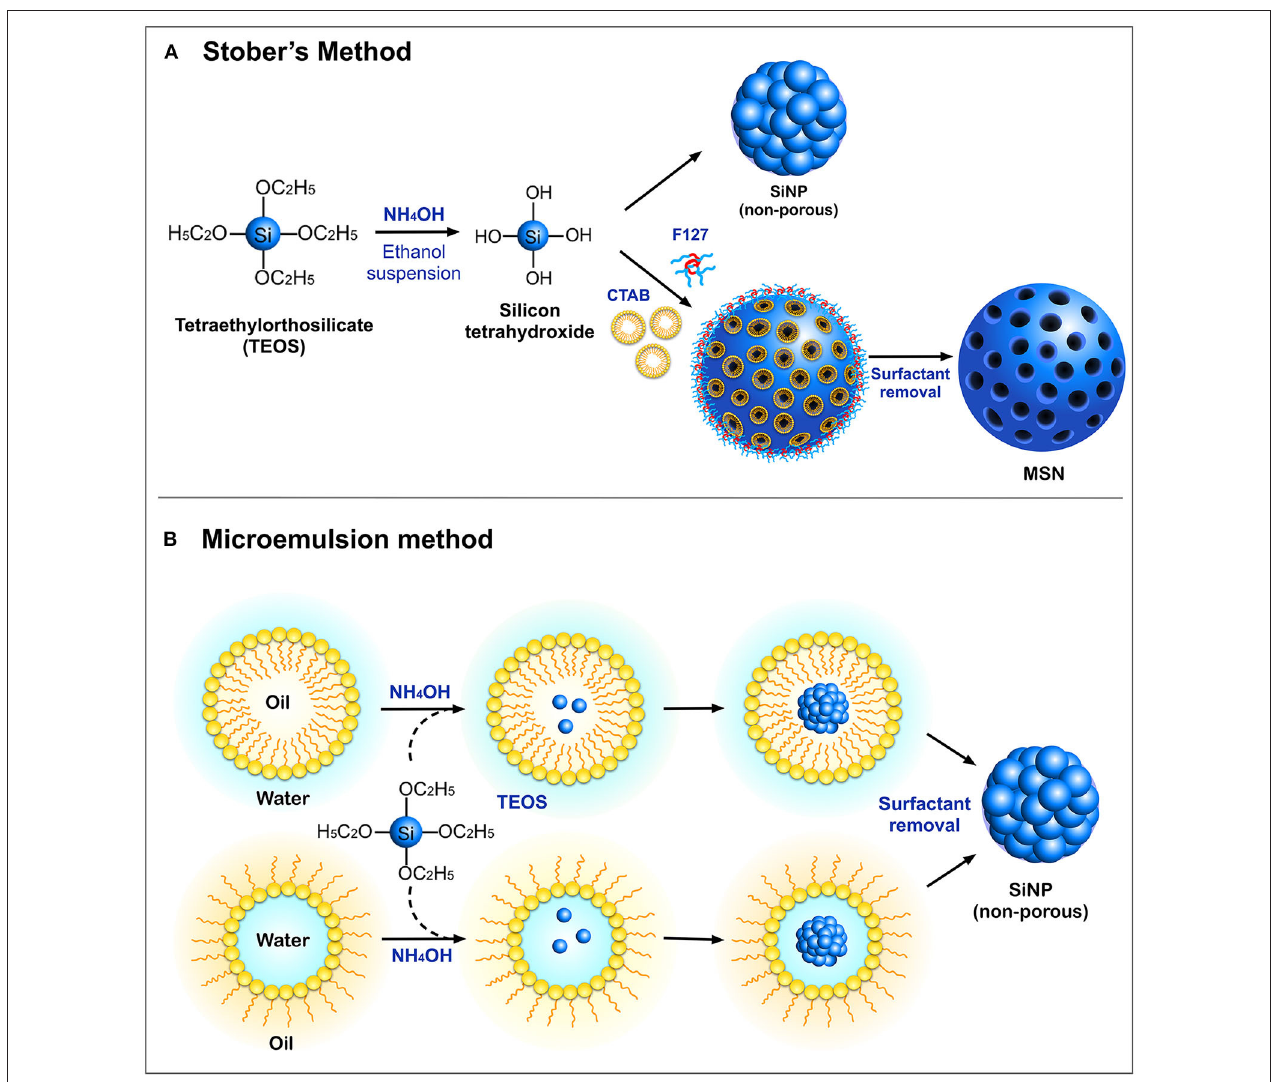
FIGURE 1 | Schematic representation of different modes of synthesis of SiNPs (A) Stober’s method and (B) Microemulsion